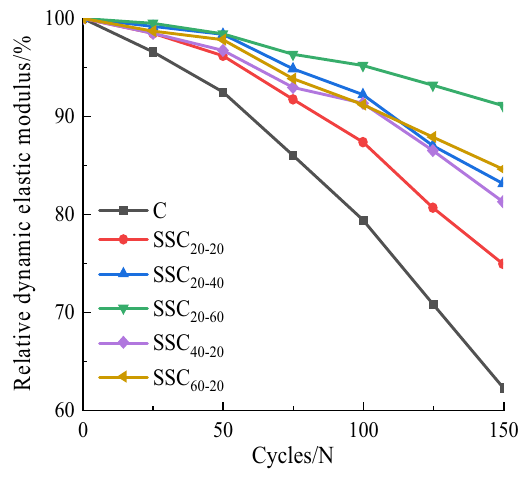
Figure 9: Relationship between relative dynamic elastic modulus and freezing - thawing